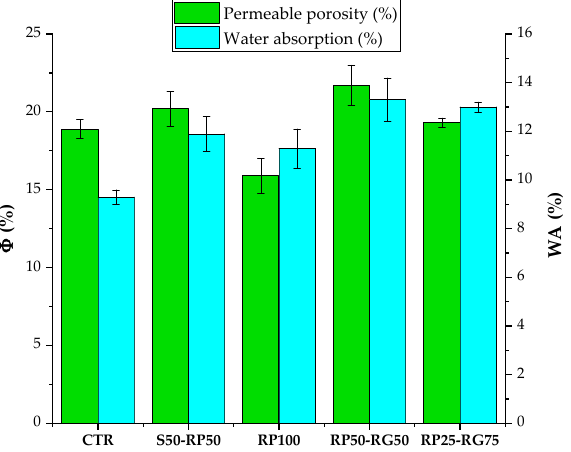
CTR Figure 9. Φ and WA: Test results. Dispersion lines in the plot represent the standard deviation. Figure 9. Φ and WA : Test results. Dispersion lines in the plot represent the standard Although porosity and water absorption are properties to be minimized in the case of load-bearing applications, both to ensure suitable mechanical strength and to increase the service life of the concrete elements (decrease the permeability of deteriorating agents and increase the corrosion resistance of steel-reinforced cement materials), their enhance- ment results in attractive requirements for the design of paving units in parking lots. As well reported by Seo et al. [28] and Grubeša et al. [29], pervious and permeable paving members are strongly functional in terms of water drainage against flooding or rainwater and resistance to freeze-thaw cycles, requiring a void ratio in the range of 15–30%. 3.2. SEM Analysis With the aim of supporting the experimental results of Φ and WA, SEM analyses were performed to evaluate the microstructural difference between CTR and rubberized samples and the variations in ITZ as a function of rubber size gradation. The secondary electron (SE) image, in Figure 10a, shows the typical spheroidal morphology of pore in CTR sample, which is associated with the air accidentally incorporated during the mixing of fresh material. Conversely, the backscattered electron (BSE) micrograph, in Figure 10b, highlights irregular voids in the matrix due to the addition of GTR. In agreement with Angelin et al. [50], irregular porous formation is intimately associated with the air trapped by the polymer aggregates. Figure 10c,d show the influence of rubber size gradation on the adhesion properties with the cement paste. The SE image, in Figure 10c, reports the poor interfacial cohesion between RG and matrix, resulting from the smoother surface texture and lower surface area of the coarser fraction than the fine one. A greater number of mechanical grinding cycles to obtain the finest fraction (RP) make the surface of the particles more rough and jagged. As shown in Figure 10d, this morphology slightly en- hances the anchoring with the matrix, resulting in an overall more compact and continu- ous interface. However, where the particle exhibits a smoother micro-texture (see the low right corner in the image), this binding effect disappears, leading to interfacial gaps. The relationship between size gradation and rubber-cement adhesion was demonstrated by the authors in previous research [20,51]. In this regard, the use of supplementary cementi- tious materials (such as silica fume) or the application of physical and chemical pre-treat- ments (silane coupling agents, NaOH, or UV-based treatment) on rubber are widely ex- plored practices to improve the interfacial GTR-cement bonding. However, further inves- tigations are still required to find cost-effective, efficient, and non-complicating for con- crete technology production methods of ITZ improvement, which are important concern- ing the field application of rubberized concrete [52].